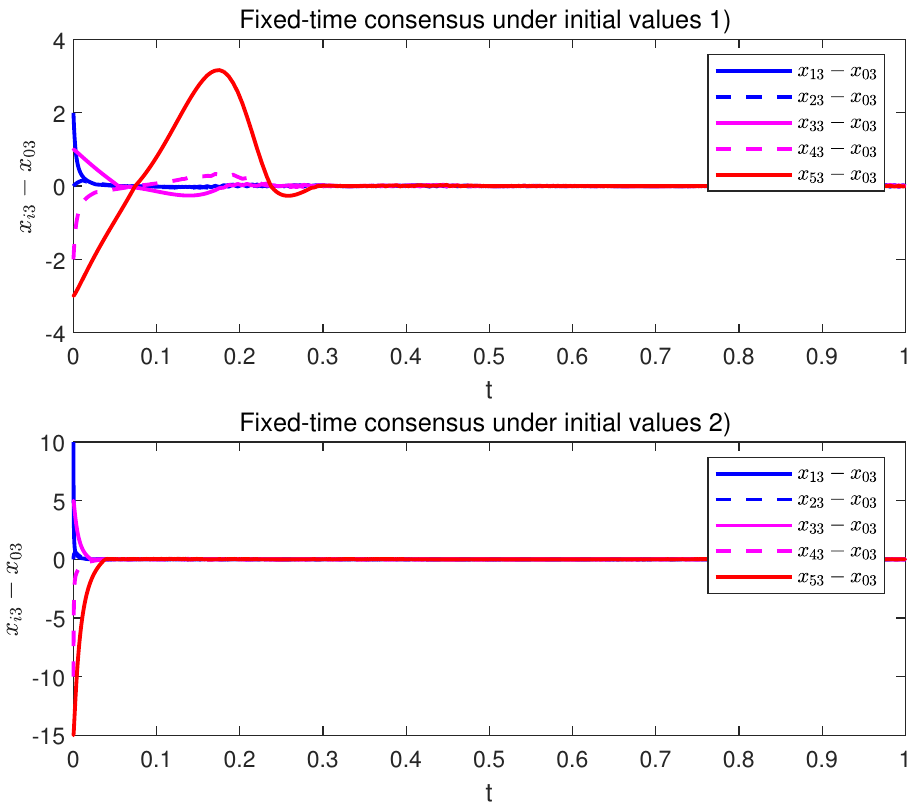
Figure 5. The trajectories of x i 3 for leader-following example under initial values (1) and (2).